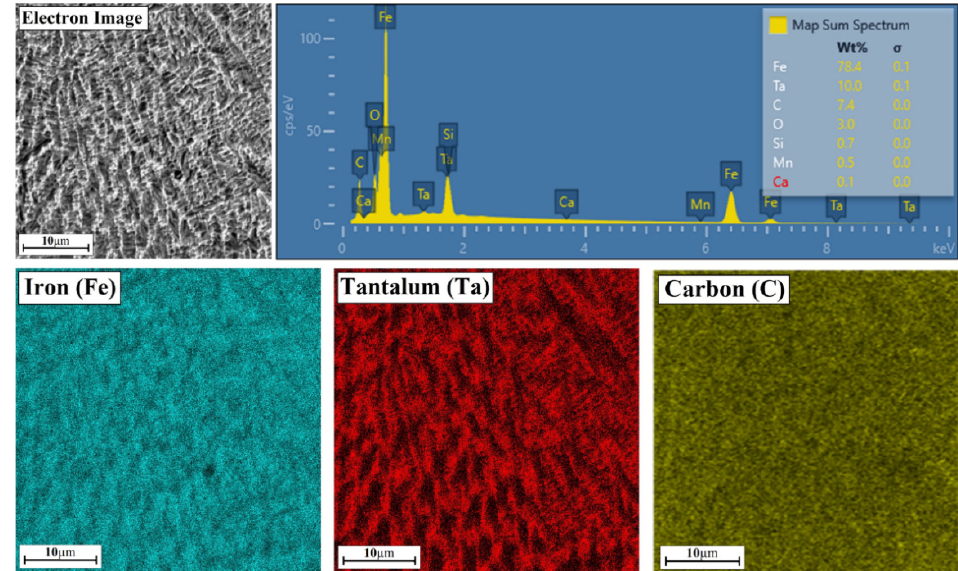
Figure 14. Chemical composition of middle area of the Fe/TaC coatings produced on tool steel using 60 µm thick pre-coat and laser beam power of 500 W.